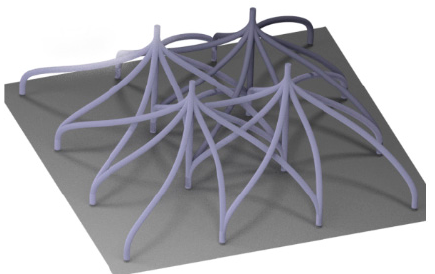
Figure 4. 3D waveguide feedforward neural network [28]. A small network hosting simple coupler. Chirality of the connections avoids the intersection of individual waveguides between the input and output ports.